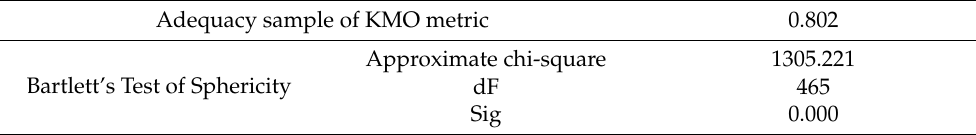
Table 4. KMO and Bartlett